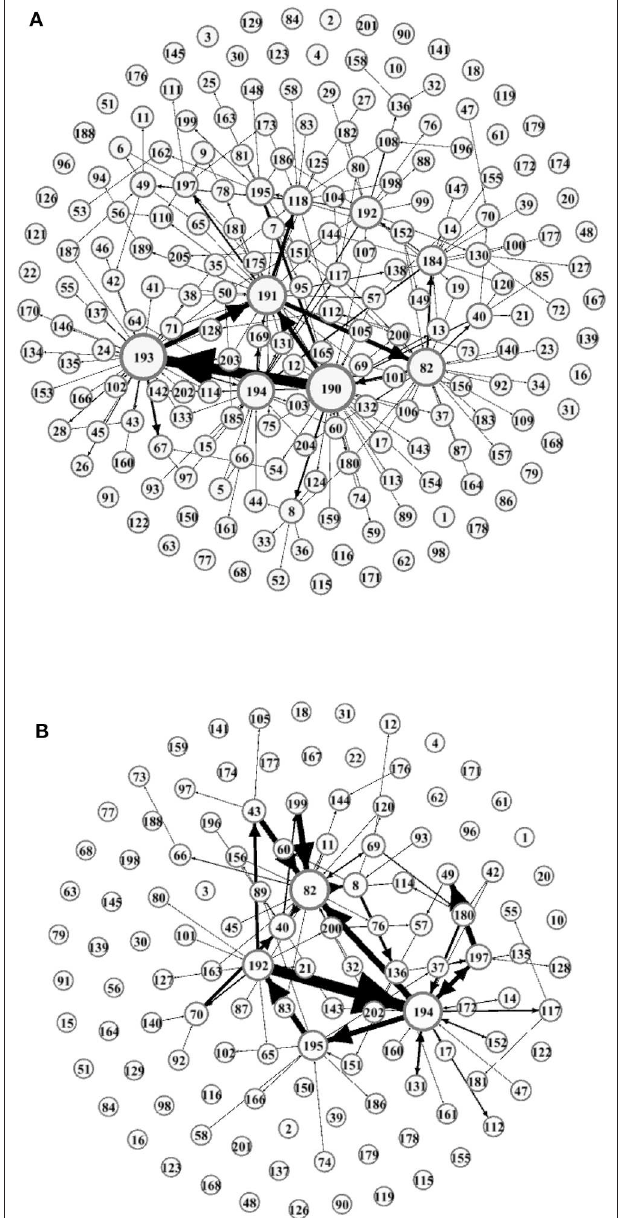
FIGURE 6 | Network structure of interbank market. (A) Represents Chinese interbank market network structure at time step t 1 . (B) Represents Chinese interbank market network structure at time step t 150 .